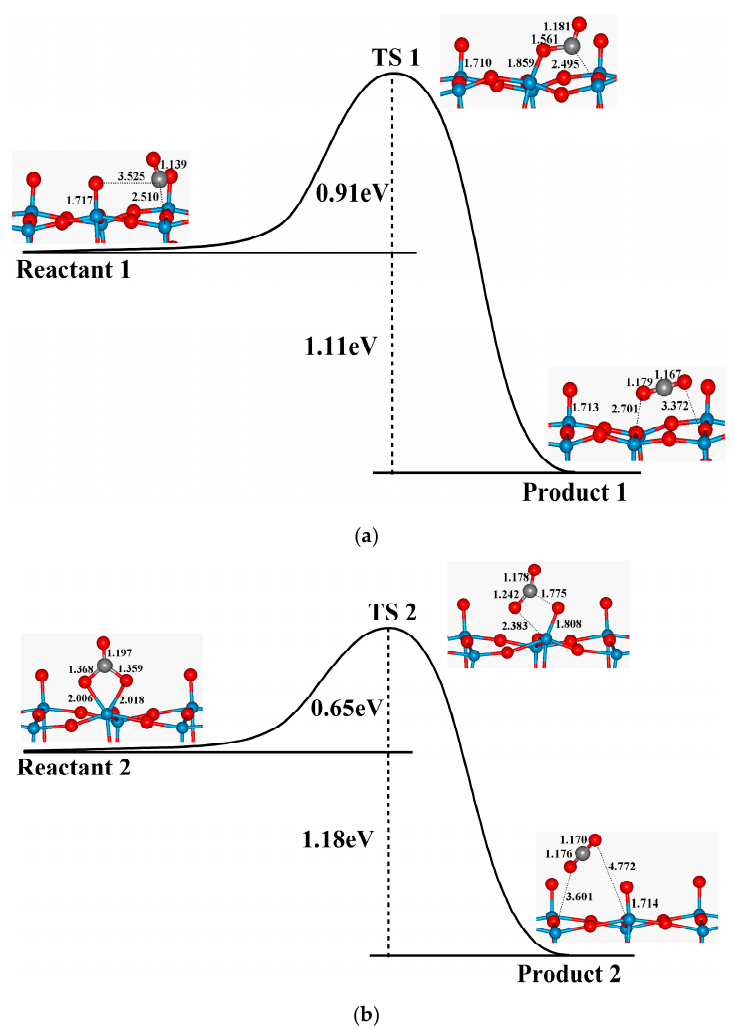
Figure 7. Minimum energy paths (MEP) for CO oxidation on ( a ) the perfect and ( b ) the O 2 pre-adsorbed WO 3 (001) surface. The configurations of the top layer and some bond distances (Å) of the initial and final states, as well as the transition state (TS) are also shown in the figures.